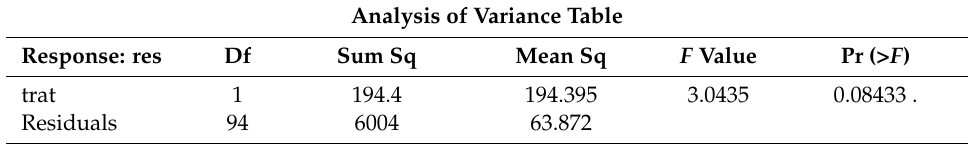
Table A12. R output of ANOVA among the residues generated from the estimation of CDM using species equation and age specific equation for C17.